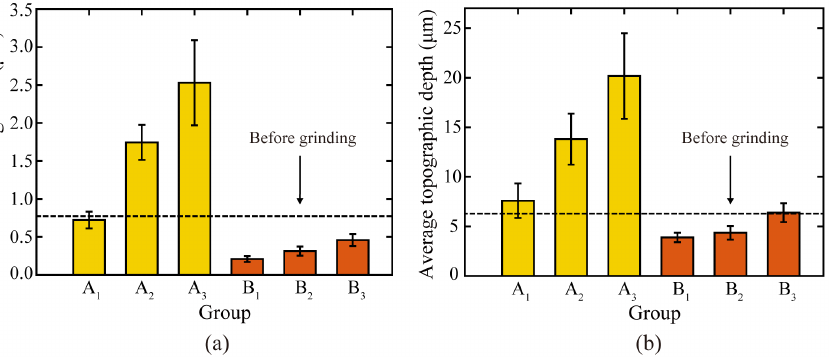
Figure 6. ( a ) Average roughness of rail samples surface and ( b ) average wear depth of grinding marks.